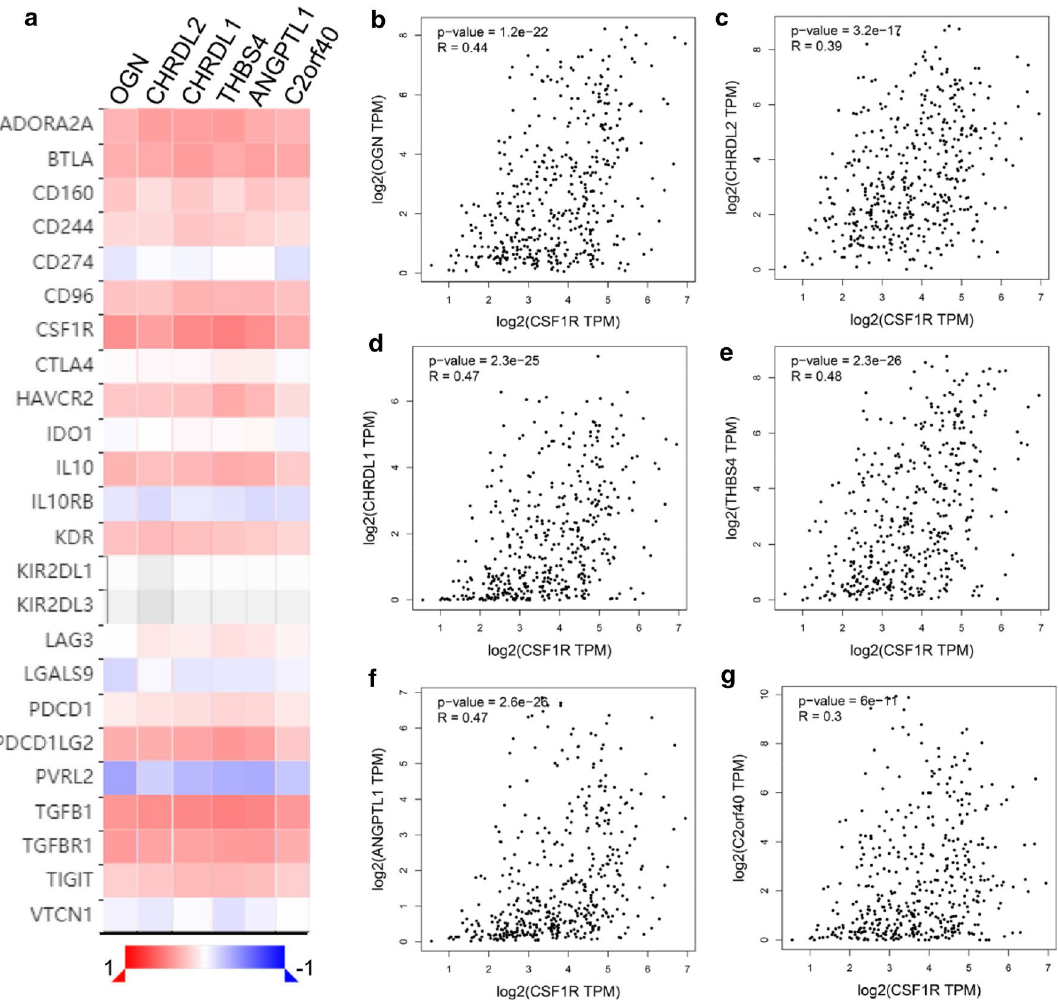
Fig. 6 Relations between the abundance of tumor-infiltrating immunoinhibitors and expression of six hub genes. a Heatmap exhibited six hub genes that were positively correlated with most immunoinhibitors base on TISIDB. b – g CSF1R had linked with six hub genes base